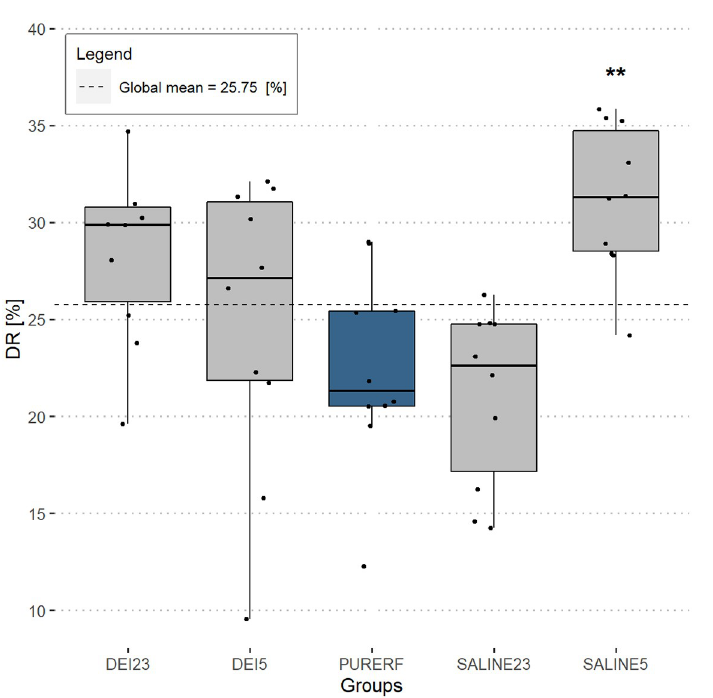
Fig 7. DR performance index. The group with saline solution at 5˚C showed the only significant difference compared to PURERF group with a DR of 31.2% and 22.4%, respectively (p = 0.006). https://doi.org/10.1371/journal.pone.0245145.g007 PLOS ONE | https://doi.org/10.1371/journal.pone.0245145 January 15,